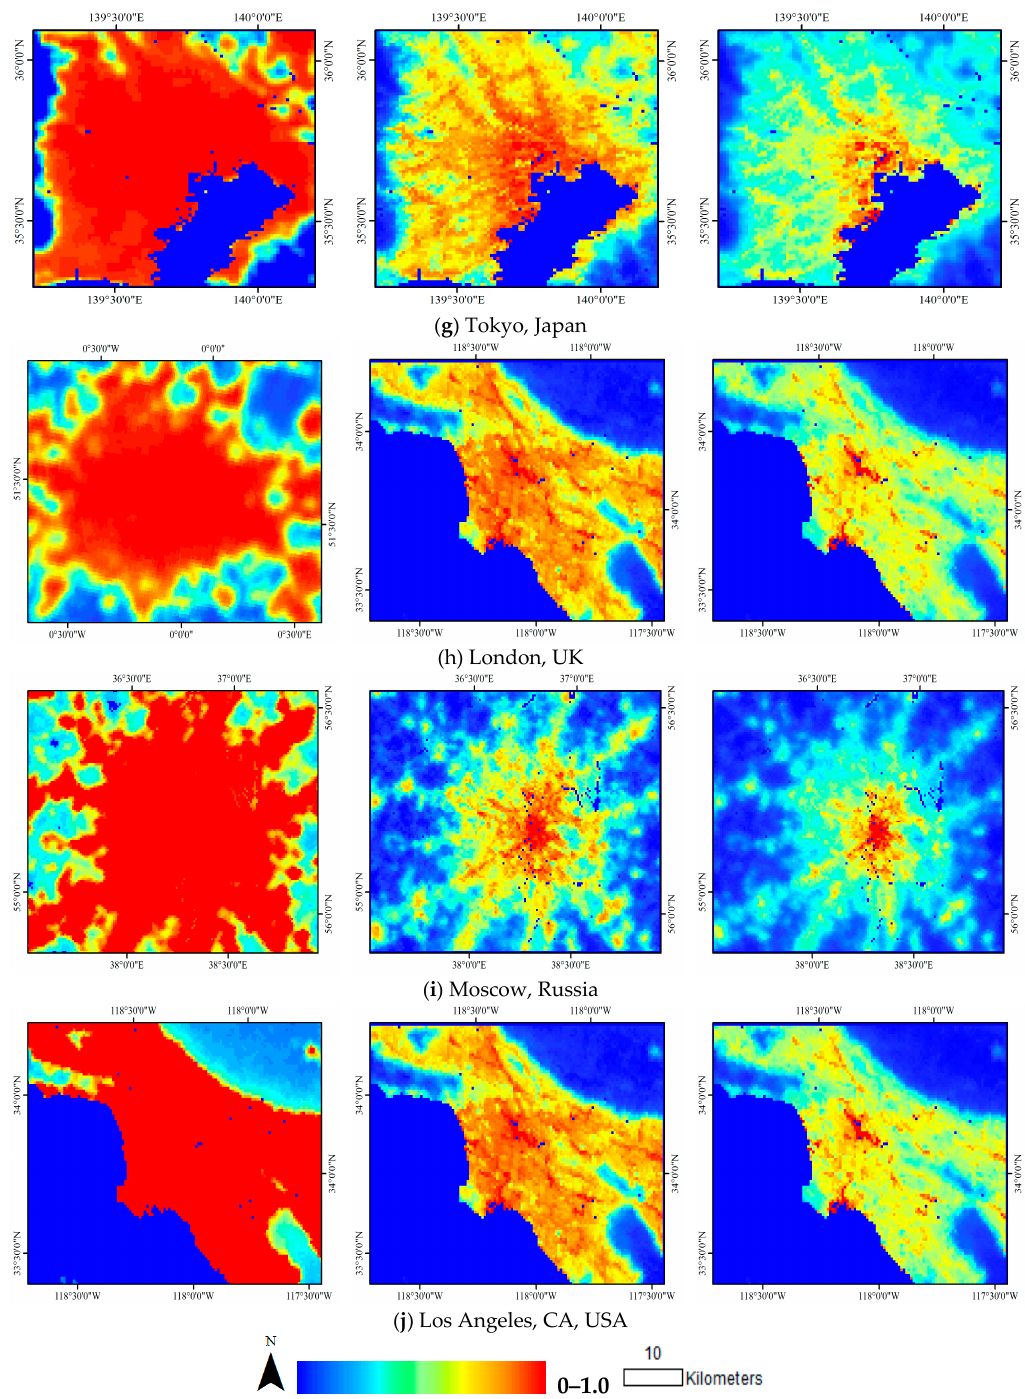
Figure 4. Comparison among original NTL images, Vegetation Adjusted NTL Urban Index (VANUI), and LERNCI-validated results in metropolises from both developing and developed countries: ( a ) Beijing, China; ( b ) Seoul, South Korea; ( c ) New Delhi, India; ( d ) Mexico City, Mexico; ( e ) Lagos, Nigeria; ( f ) New York City, NY , USA; ( g ) Tokyo, Japan; ( h ) London, UK; ( i ) Moscow, Russia; ( j ) Los Angeles, CA, USA.